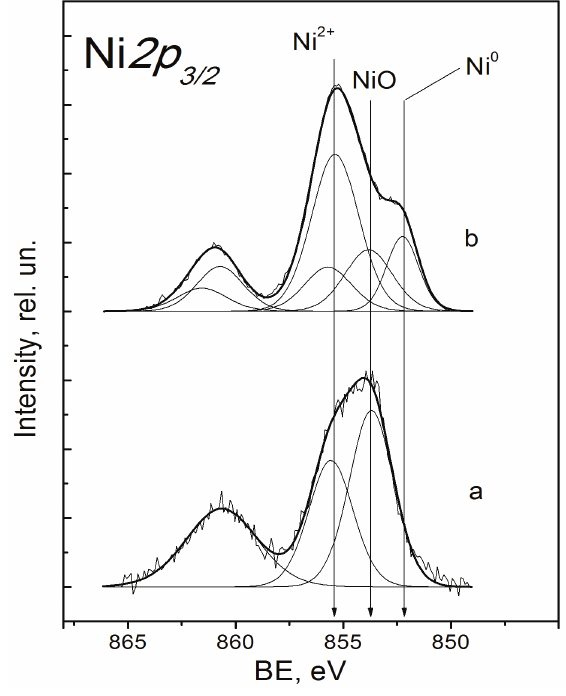
core-level spectra for the Ni/B2 sample: a – Figure 7: The Ni 2p 3/2 fresh, b – spent.